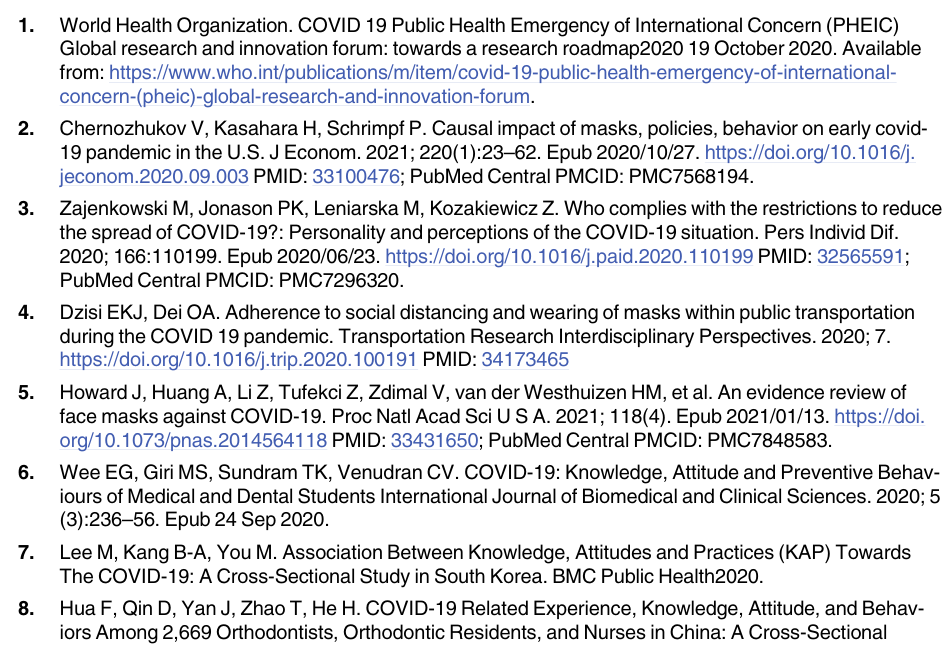
S2 Table. Standardized residuals of chi-square test performed on the demographics of the study participants (n = 6,518). S1 Dataset. Study